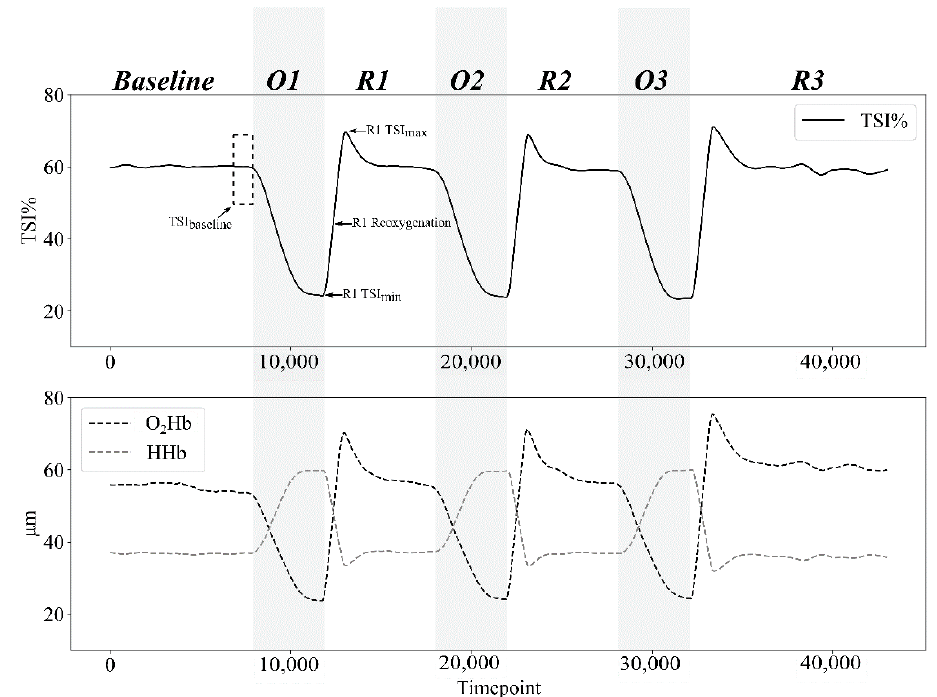
Figure 3. Example of tissue saturation index (TSI%), oxyhemoglobin concentration ([O 2 Hb]) and deoxyhemoglobin concentration ([HHb]) responses during the whole protocol for a single participant in group 3 (G3: 250 mmHg). The dashed rectangle represents the last minute of the baseline, which is averaged to provide the baseline value of each parameter. When the cuff is inflated during occlusion phases (O1, O2, O3), both TSI% and [O 2 Hb] decrease until their minimum, whereas [HHb] increases to its maximum. When the cuff is deflated at the beginning of reperfusions phases (R1, R2, R3), TSI% and [O 2 Hb] rise until their maximum above the baseline value (hyperemia spike), whereas [HHb] reach its minimum.